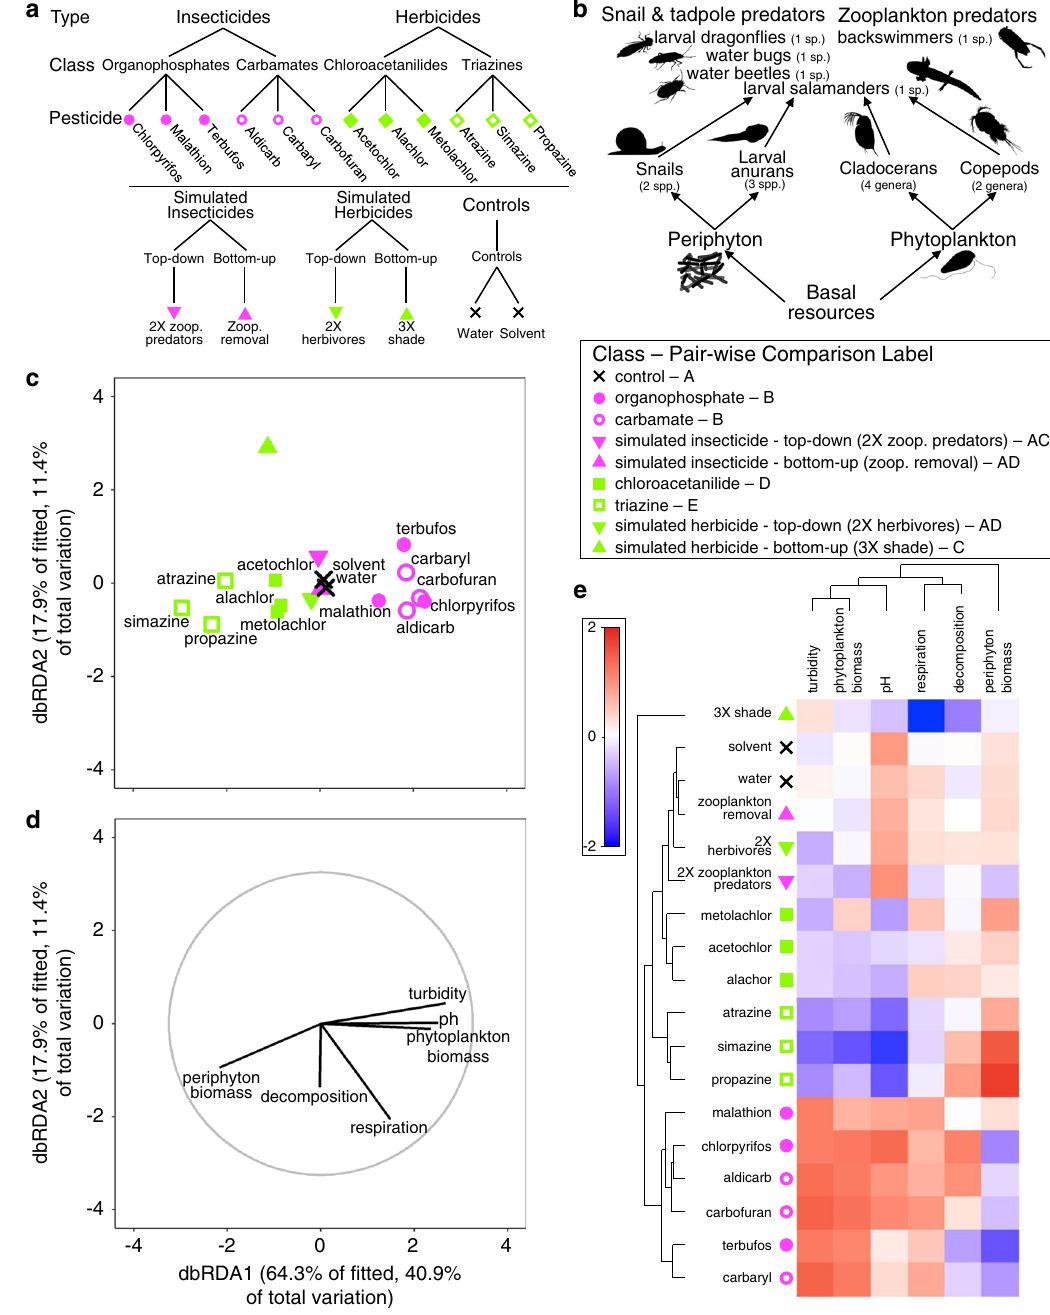
Fig. 1 Experimental design and similarity of ecosystem responses by pesticide type. a Experimental design showing hierarchical structure of treatments. Each treatment was replicated four times with mesocosm as the replicate. b Food web diagram of experimental communities. c Distance-based redundancy analysis (dbRDA) plot of multivariate ecosystem responses showing differences among treatments grouped by pesticide type. Individual points are the centroids of 18 treatments in the experiment. For pair-wise comparisons, treatments sharing letters are not different from each other. d Vector overlay of ecosystem responses for the corresponding dbRDA plot. The gray circle corresponds to vector lengths that would have a correlation coef fi cient of one with each axis. e Cluster diagram of experimental treatments and ecosystem-level responses showing grouping of experimental treatments according to pesticide type. The scale bar shows the magnitude of the effect of a treatment on an individual response. The values of the colors correspond to the averaged and normalized treatment responses (see “ Methods ” section). Attribution of silhouettes: periphyton (created by Matt Crook, license link, image has been rotated), anuran tadpole (created by M. Mahon (vectorization), J.J. Harrison (photography), photo license link, photo changed to silhouette), A. junius (created by M. Mahon (vectorization), Dave Huth (photography), photo license link, photo changed to silhouette), B. fl umineum (created by Dave Angelini, license link, image was rotated), and Hydrochara (created by T. Michael Keesey (vectorization), Yves Bousquet (photography), license link, image was